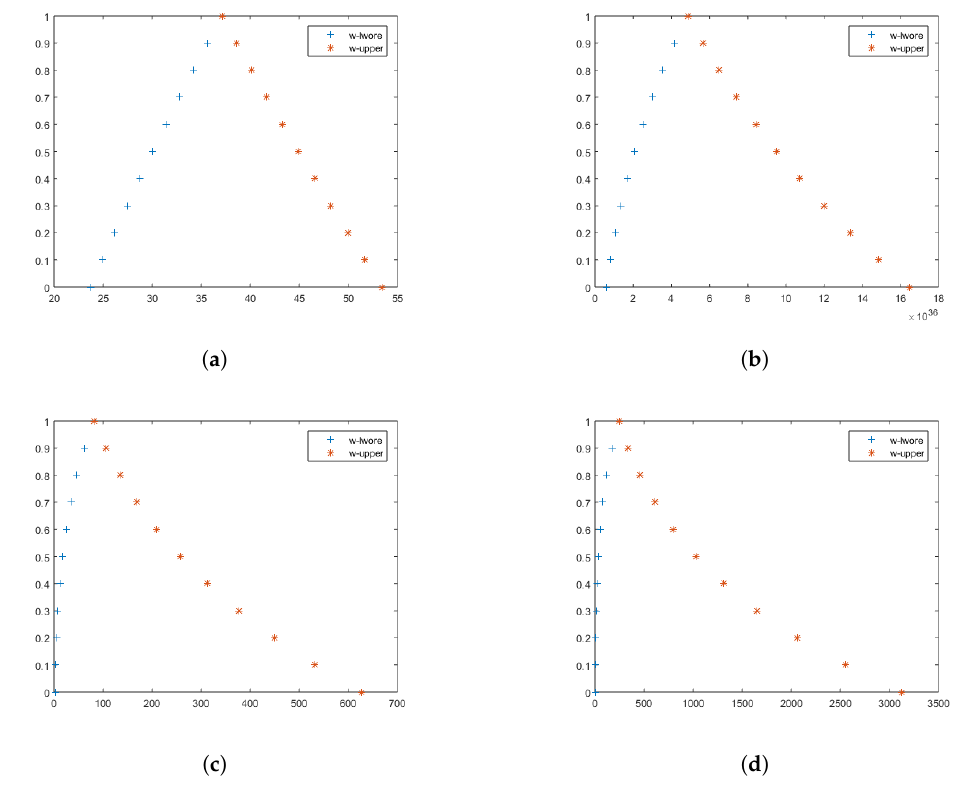
Figure 1. ( a ) Ex (4.1) ψ = 3, ρ = 1, (cid:96) = 2, t = 4, n = 2; ( b ) Ex (4.2) ψ = 30, t = 0.0001, n = 3; ( c ) Ex (4.3) ψ = 0.0002, t = 0.01, n = 4; ( d ) Ex (4.4) ψ = 0.0002, t = 0.01, n =